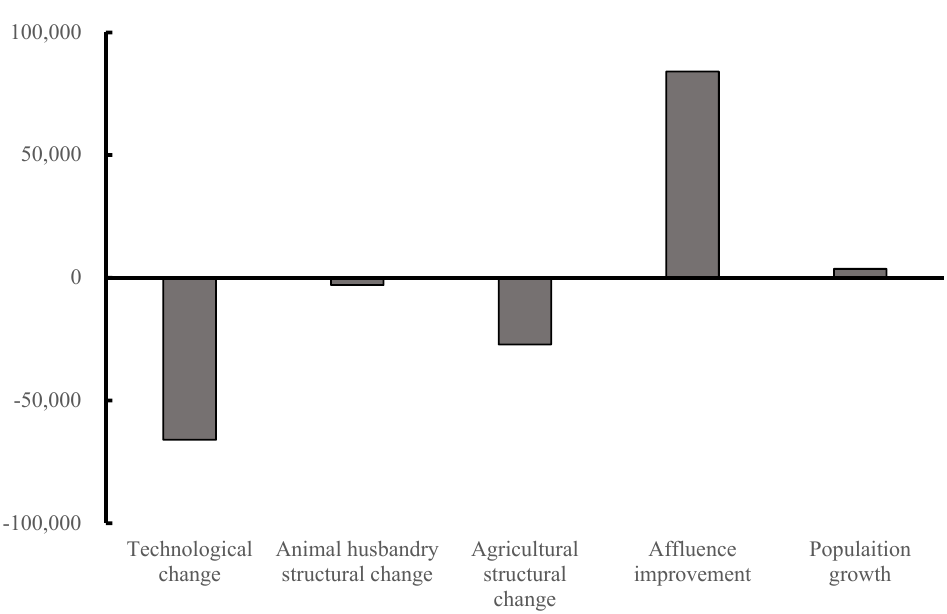
Figure 1. The results of summation and decomposition of total driving effects (units: 10,000 tons).